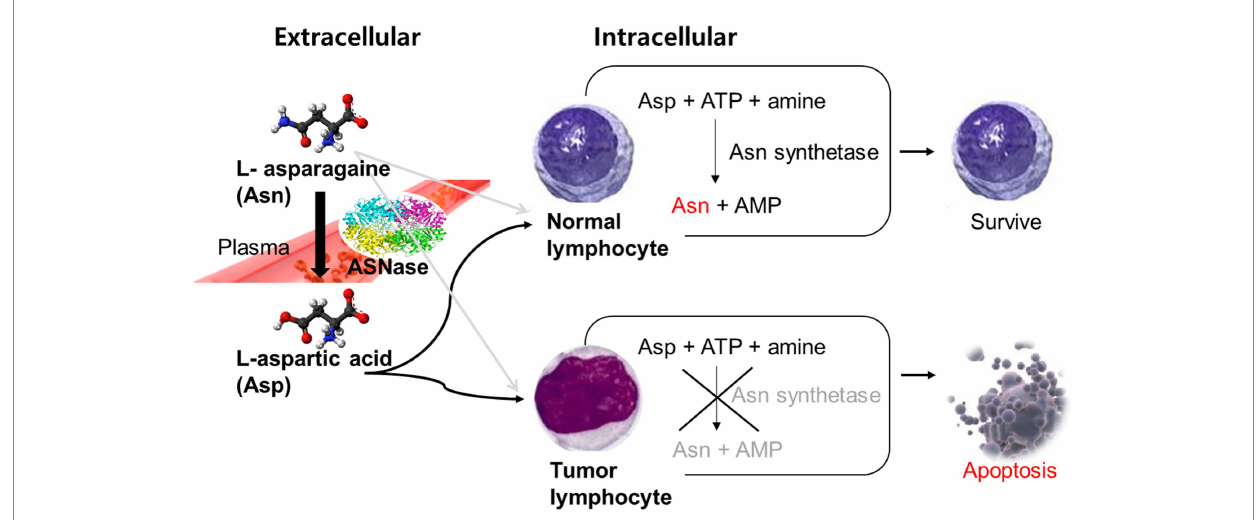
FIGURE 1 Mechanism of L-asparaginase in tumor cells. Asn, L-asparagine; ASNase, Asparaginase; Asp, L-aspartic acid; ATP, Adenosine triphosphate; AMP, Adenosine